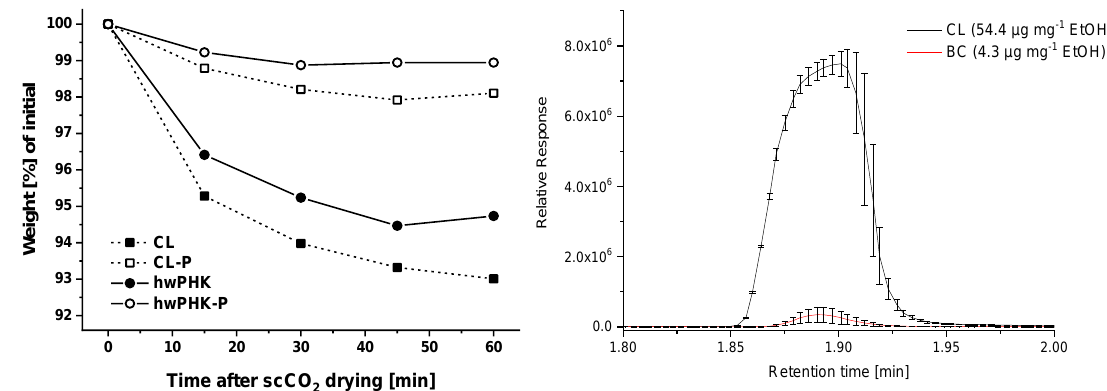
Figure 5. Weight [%] of the materials recorded over 60 min after scCO 2 drying (left). Release of ethanol from freshly scCO 2 dried cotton linters aerogels (CL) and bacterial cellulose aerogels (BC) under headspace (80 °C) GC-MS conditions (right).